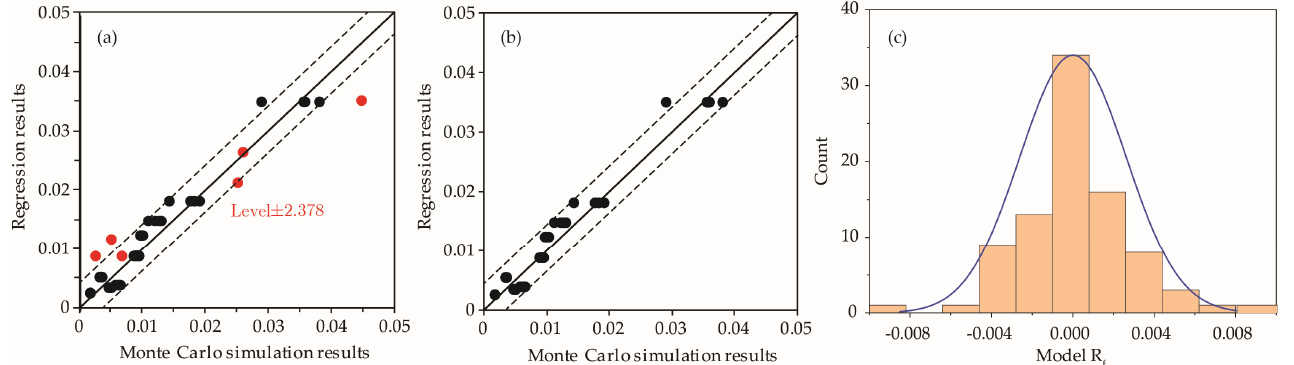
Figure 11. ( a ) Regression and Monte-Carlo simulation results with all data points displayed; ( b ) regression and Monte-Carlo simulation results with extreme mass fraction and diameter removed from the plot; and ( c ) residual error distribution for model-R f .